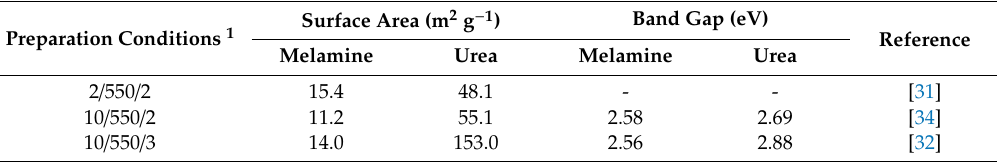
Figure 1. Structures of melam, melem, melon, and fully condensed graphitic carbon nitride. Table 1. Specific surface area (SSA) and band gap energy (EG) for carbon nitrides obtained under various conditions (literature data)